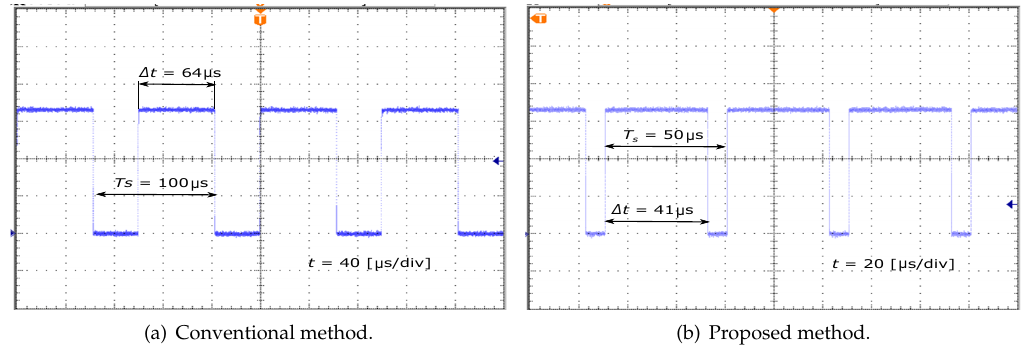
Figure 19. Experimental results of the proposed method with I f = 3 A.